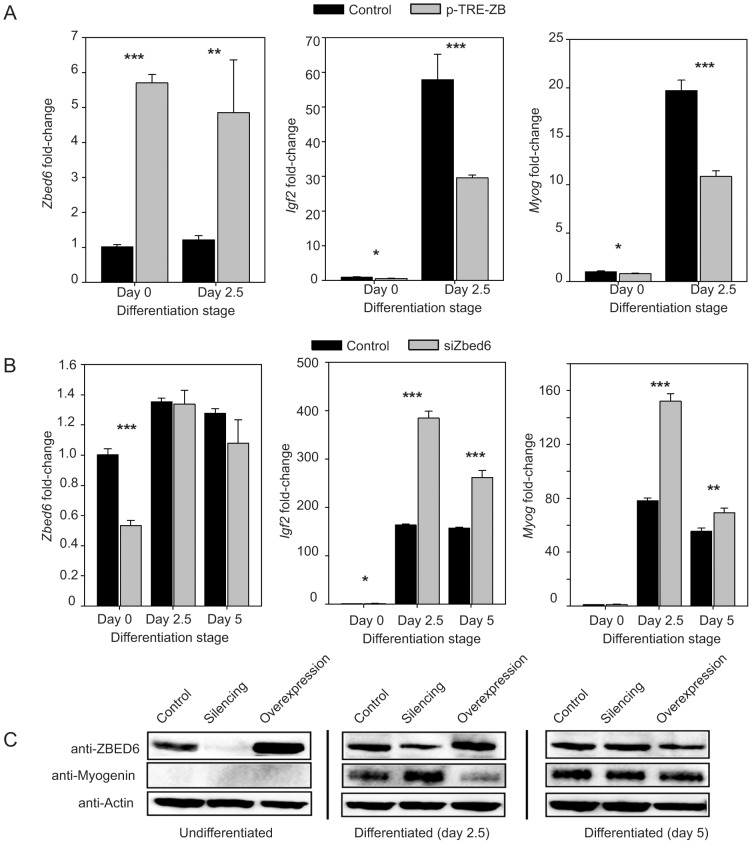
ZBED6 modulates the expression of Igf2 and Myogenin during differentiation of C2C12 cells.(A) Expression of ZBED6, IGF2 and Myogenin mRNA monitored by qPCR before and after differentiation of control cells and transfected cells overexpressing ZBED6 from the pTRE-ZB vector. (B) Expression of ZBED6, IGF2 and Myogenin mRNA monitored by qPCR before and after differentiation of control cells and cells in which ZBED6 has been silenced using siRNA. (C) Western blot analysis confirming altered expression of ZBED6 and Myogenin at the protein level. Actin was used as loading control.